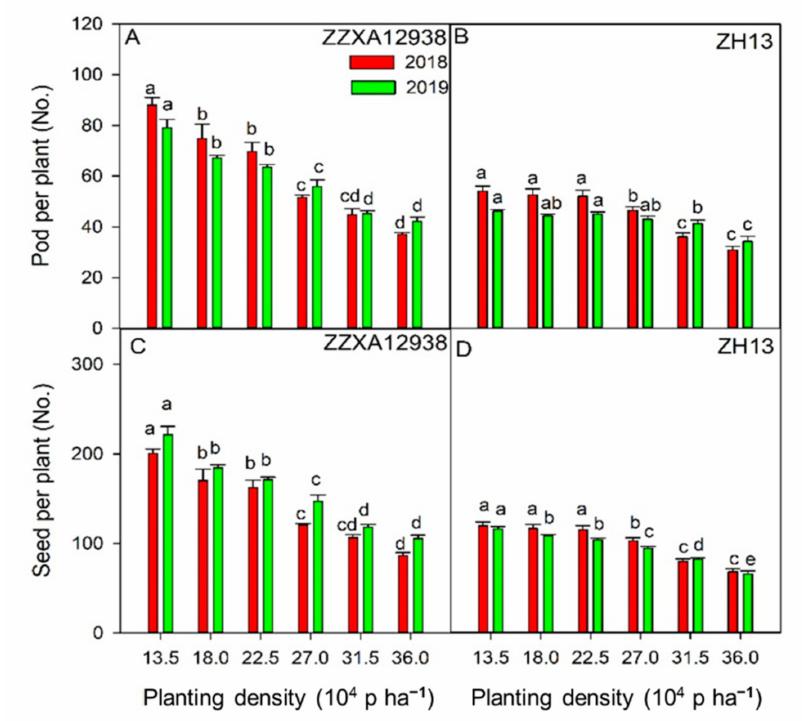
Figure 1. Pod and seed number per plant as an effect of planting density and cultivar (( A , C ): ZZXA12938; ( B , D ): ZH13). Error bars represent the standard deviation of the mean. Different lowercase letters in the same year indicate significant differences among the treatments ( p ≤ 0.05).